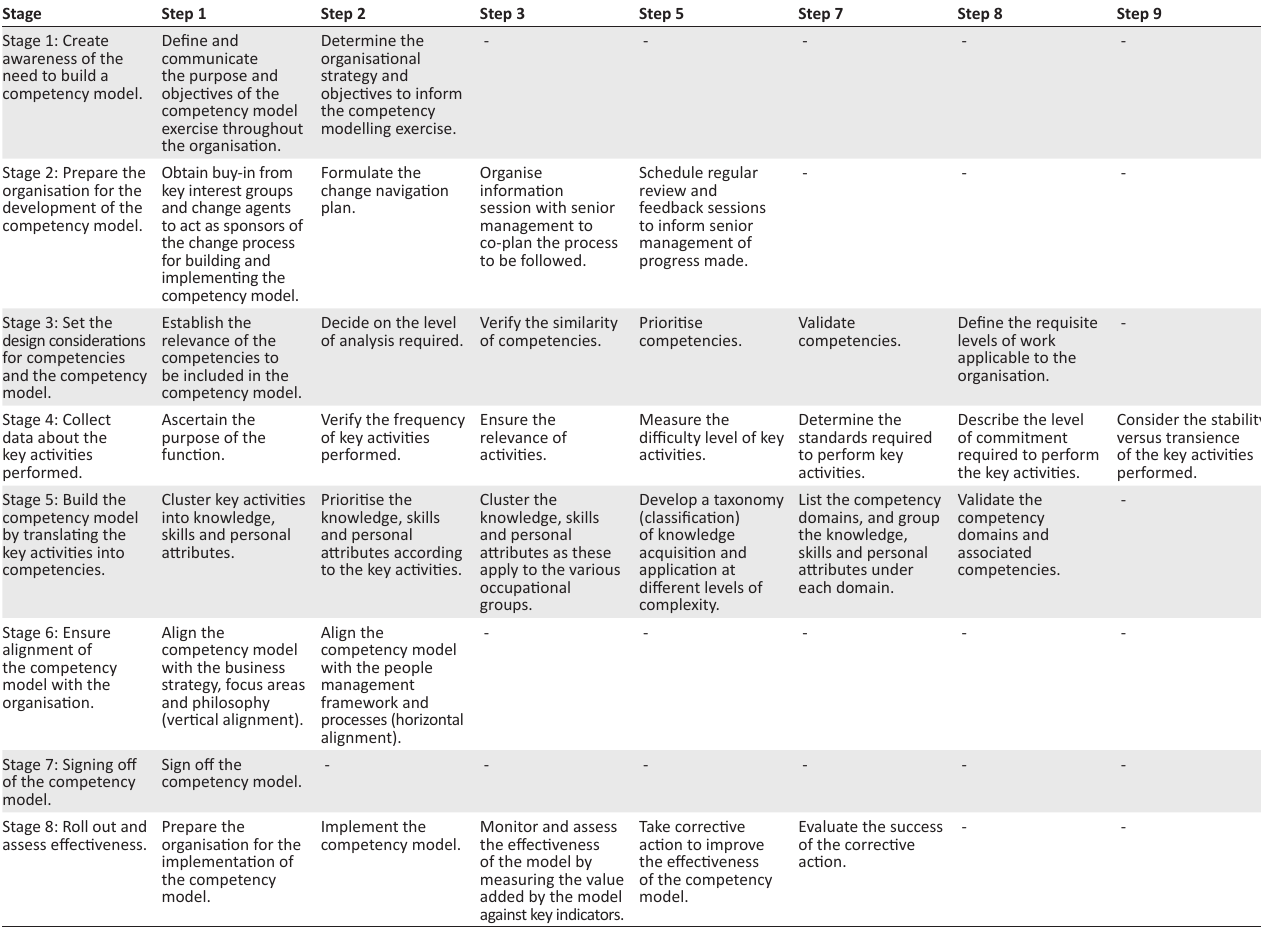
TABLE 1: The competency modelling stages with their commensurate